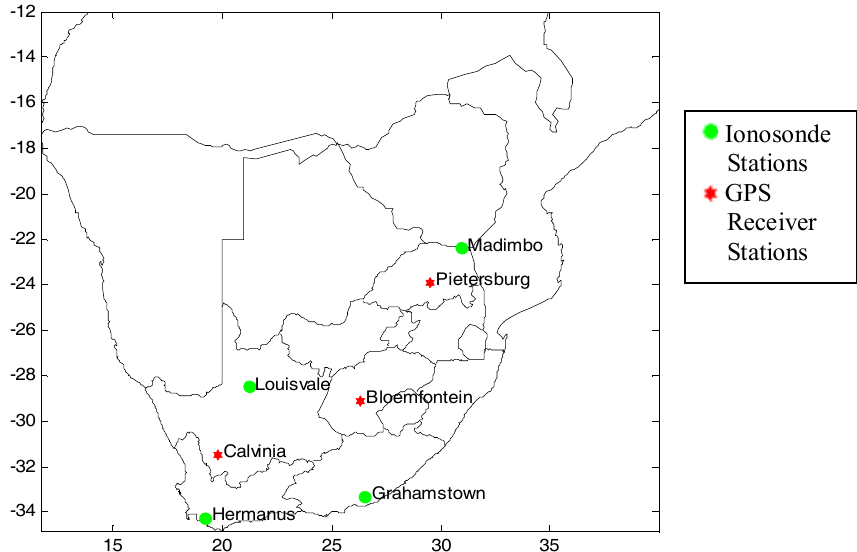
Fig. 6. Location of the ionosonde stations and the GPS receiver stations used for the validation of the TEC values obtained from the map. Table 1. Correlation coefficients between GPS-TEC values, IRI-TEC values and MAP-TEC values. Correlation coefficient between Correlation coefficient between Station GPS-TEC and IRI-TEC GPS-TEC and MAP-TEC